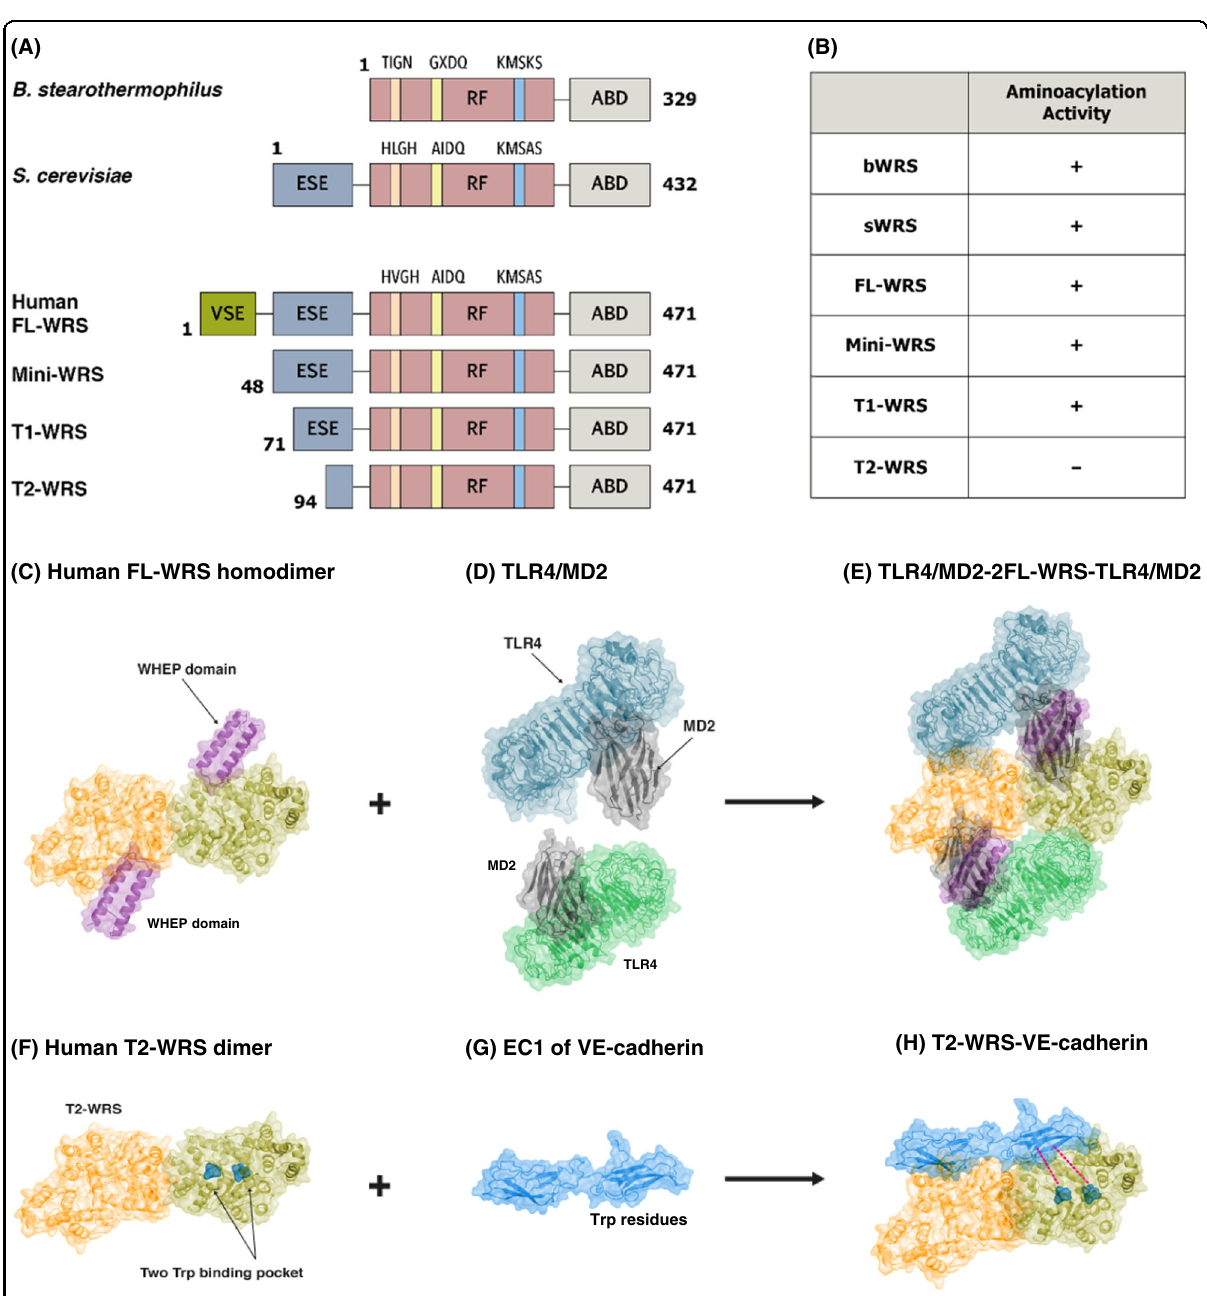
Fig. 2 Various structures of WRS and their interactions with speci fi c receptors. a Schematic representation of domains in WRS from prokaryotes ( B. stearothermophilus ), lower eukaryotes ( S. cerevisiae ), and higher organisms ( H. sapiens ). The Rossmann Fold (RF) catalytic domain and anticodon- binding domain (ABD) are well conserved in all WRSs. In the RF domain, the three characteristic types of motif have slightly different sequences among species. The eukaryotic-speci fi c extension (ESE) is common in eukaryotic WRSs. Human full-length (FL)-WRS also has the vertebrate-speci fi c extension (VSE) at the N-terminal appended site. Alternative splicing can produce a mini-WRS where a portion of the VSE is truncated. After being secreted into the extracellular space, the T1 and T2-WRSs are generated by proteolytic cleavage, which removes the ESE, including the entire VSE sequence. b The aminoacylation activity of the various forms of WRSs in different species. All the WRSs, with the exception of T2-WRS, are capable of aminoacylation. c – h Representative model of the structural arrangement of WRS and their speci fi c interactions with receptors. FL-WRS ( c ), dimeric human FL-WRS (PDB 1R6T) binding to two TLR4/MD2 heterodimers (PDB 3FXI) through the WHEP domain and the N154 terminus in trans ( d , e ), T2- WRS (PDB 1O5T) with truncated WHEP entirely cuts off the N-terminus ( f ), interaction of T2-WRS with the EC1 domain in VE-cadherin (PDB 3PPE). Trp residues present in the EC1 domain bind to the Trp binding pocket present in the RF domain of WRS ( g , h